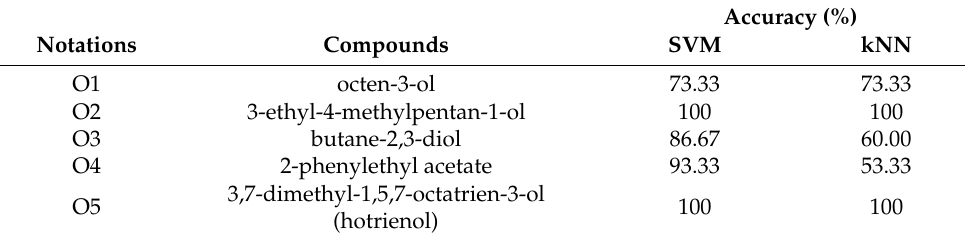
Table 4. Subsets formed from selected